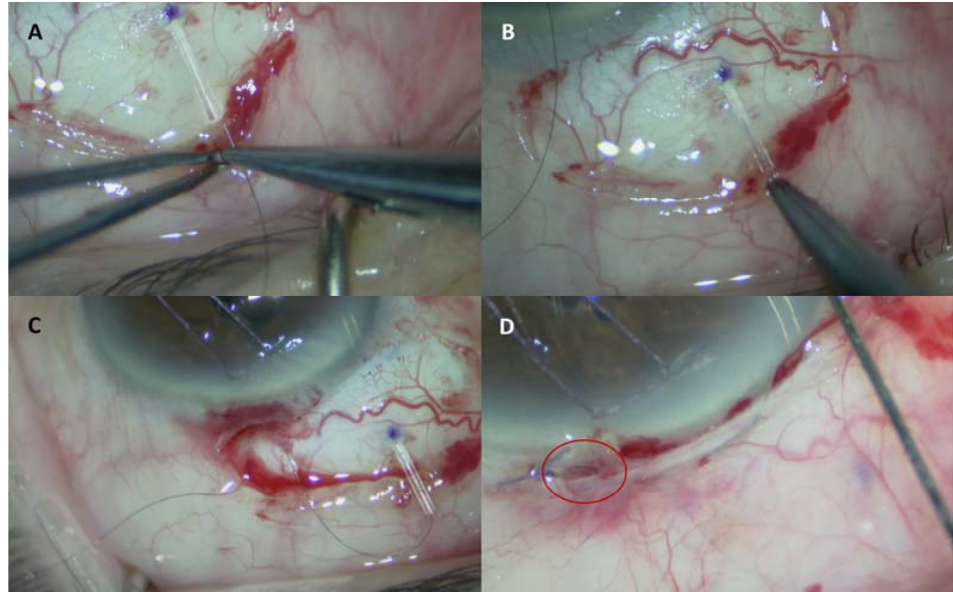
Figure 1 . Intraoperative images showing the surgical steps of intraluminal stent insertion. ( A ) A 10.0 nylon suture is inserted in the outer lumen of the PMS. ( B ) The suture is advanced inside the PMS lumen to reach the inner end. ( C ) The external part of the suture is buried in a limbal corneal grove. ( D ) Image showing the suture loop protruding from the conjunctiva enables easy postoperative ac ‐ cess.